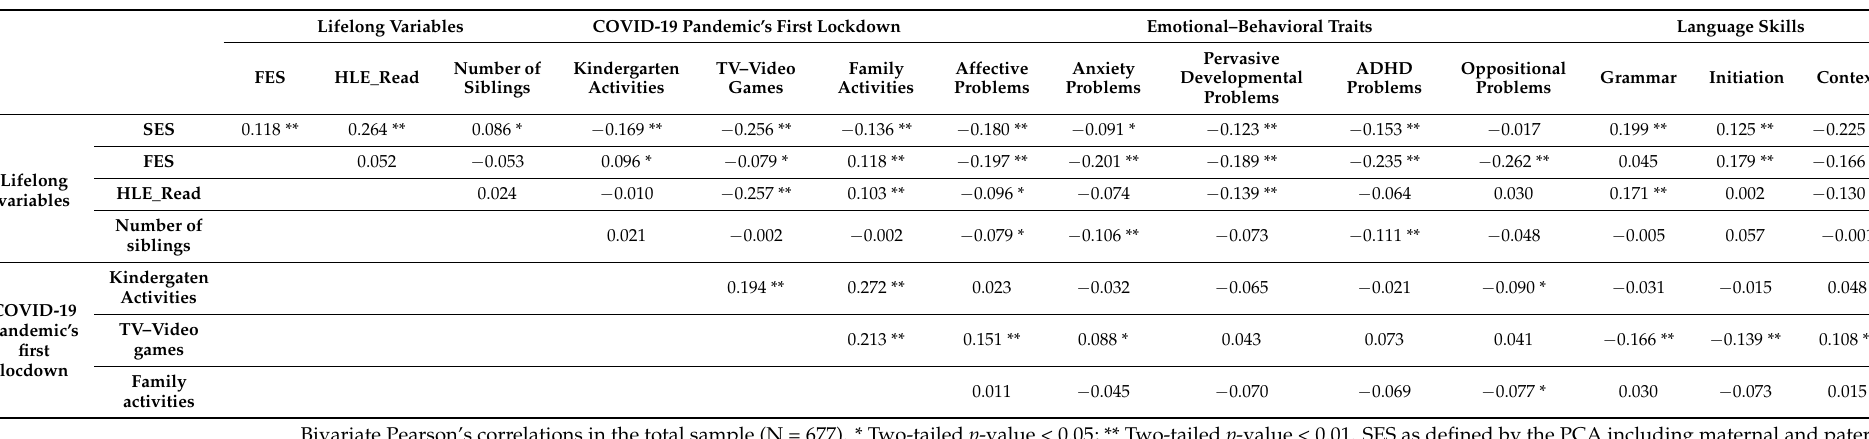
Table 3. Correlations between lifelong variables, activities during the COVID-19 pandemic’s first lockdown, emotional/behavioral traits, and language